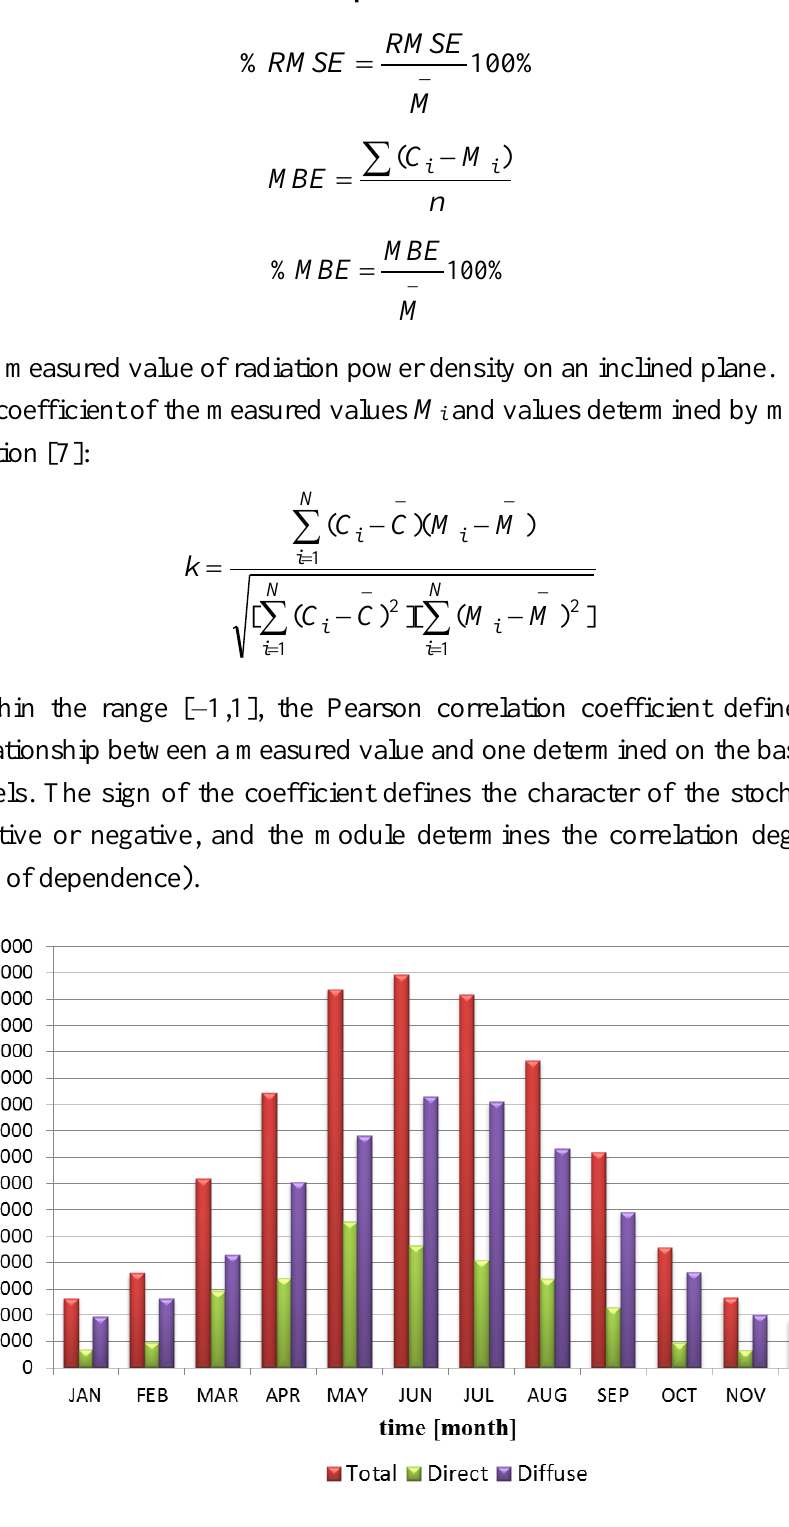
Figure 2. Distribution of solar radiation during the year including total, direct and diffuse components for the city of Poznan, based on